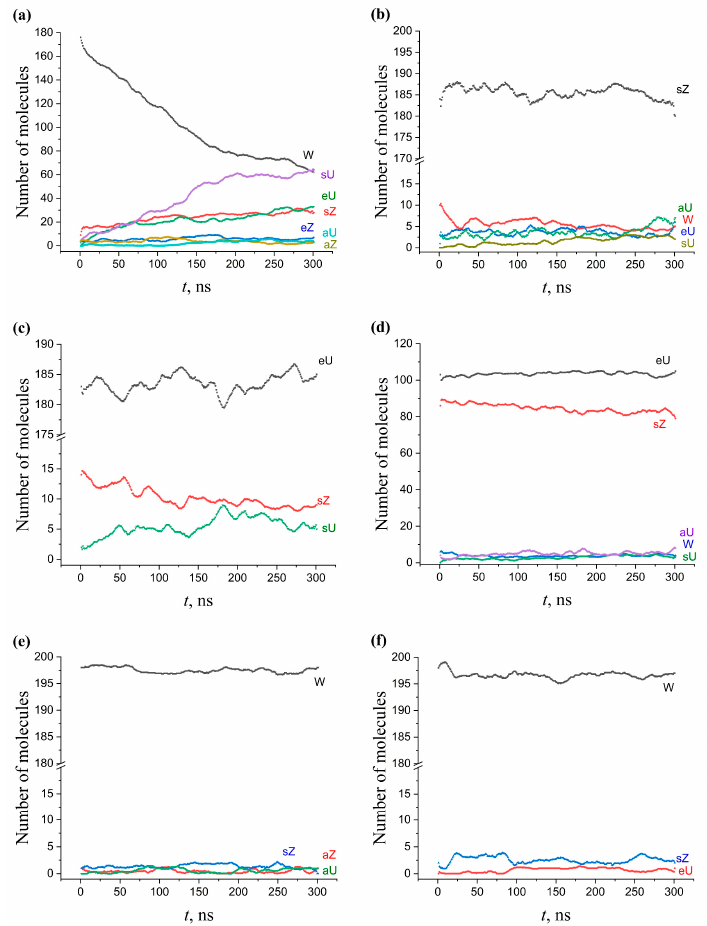
Figure 6. Conformation changes in the single-component membranes during 300 ns MD. ( a ) AMA- W, ( b ) AMA-sZ, ( c ) AMA-eU, ( d ) AMA-sZ+eU, ( e ) KMA-W, ( f ) MMA-W. ( b ) AMA-sZ, ( c ) AMA-eU, ( d ) AMA-sZ+eU, ( e ) KMA-W, ( f ) MMA-W.